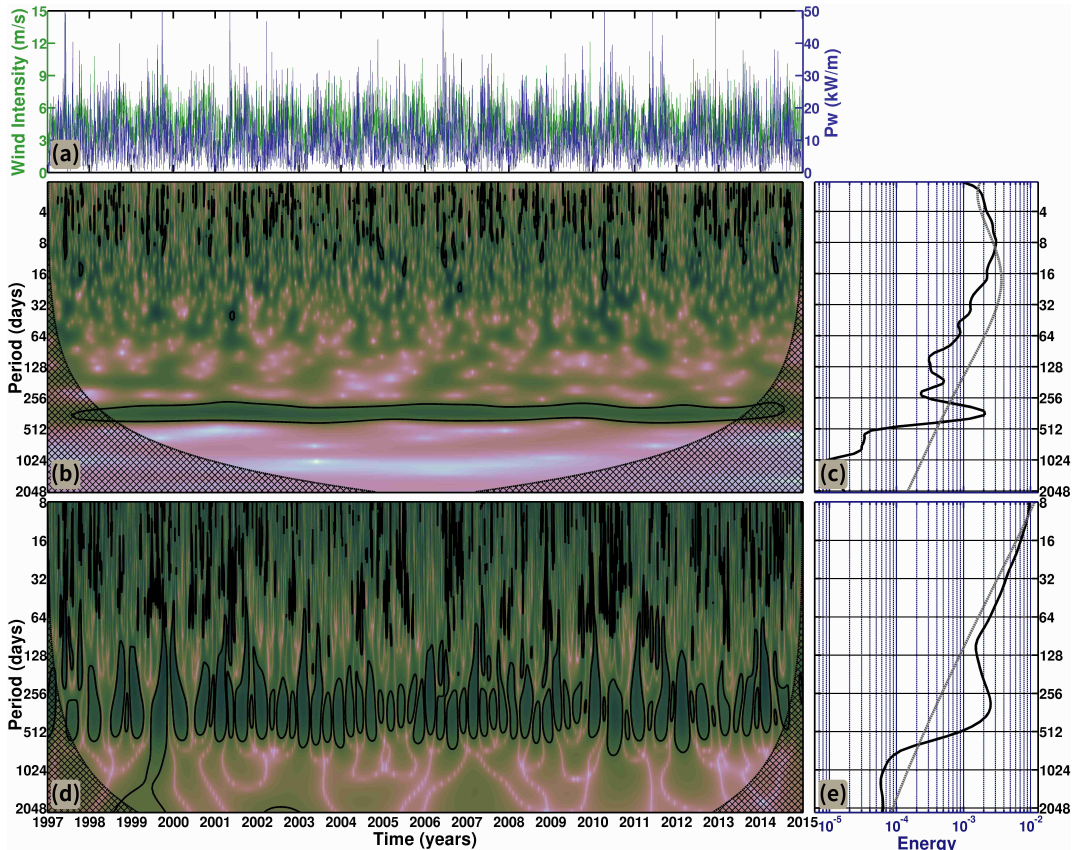
Figure 12. ( a ) Time series of wind intensity (blue) and P w (green) used for the cross-wavelet analysis. ( b ) Local Morlet wavelet power spectrum. Thick contour lines enclose regions of greater than 95% confidence for a red noise process with a lag1 coefficient of 0.7. Cross-hatched regions indicate the cone of influence where edge effects become important. ( c ) Global Morlet power spectrum of the time series and the dotted line indicate the 95% confidence level. ( d ) Mexican Hat local wavelet power spectrum. Thick contour lines enclose regions of greater than 95% confidence for a red noise process with a lag1 coefficient of 0.1. Cross-hatched regions indicate the cone of influence where edge effects become important and. ( e ) Global Mexican Hat power spectrum of the time series and the dotted line indicate the 95% confidence level on the coastal zone of Ilhabela. Cube Helix color scheme developed by Green